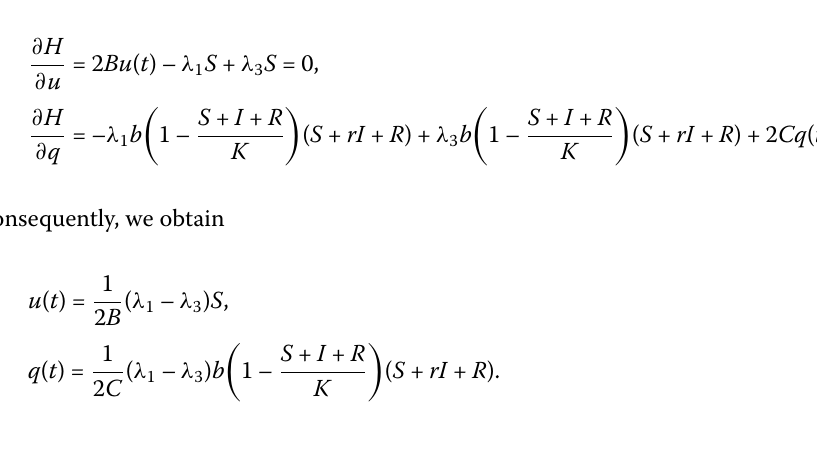
tional is described by